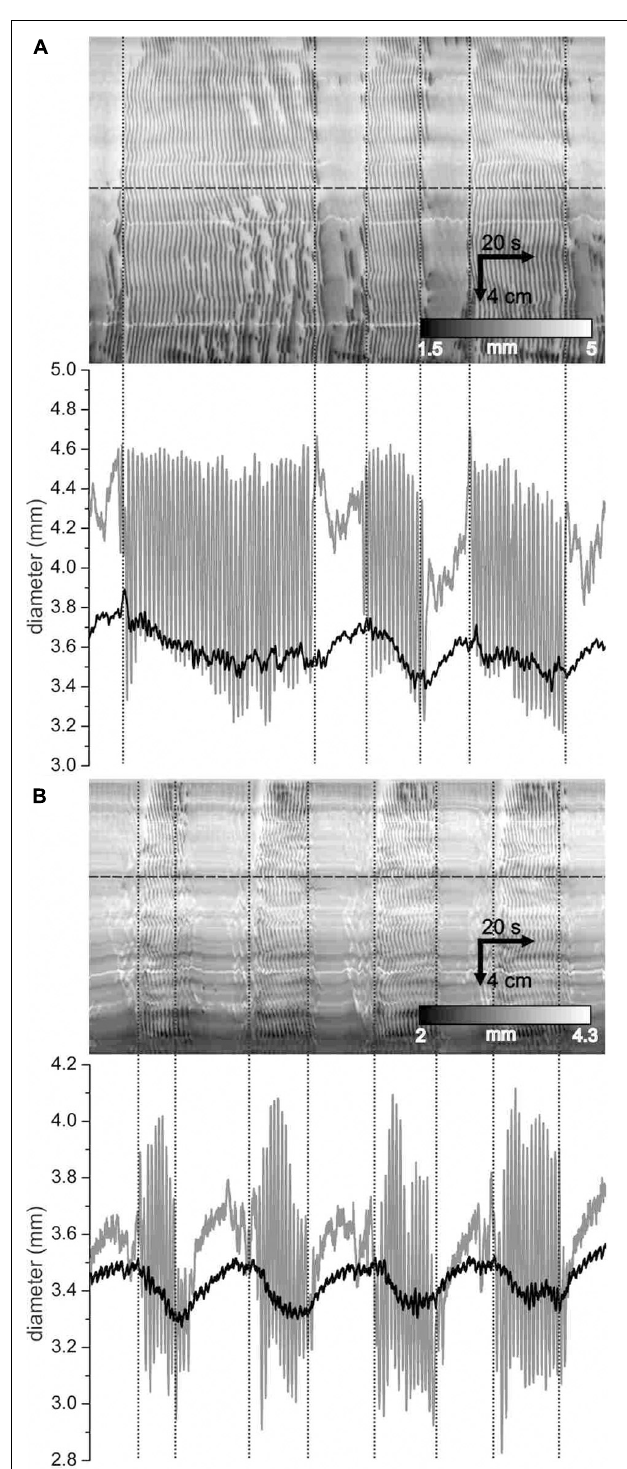
FIGURE 10 | Distension of the intestine during gaps. (A,B) DMaps (top) and their mean diameter (bottom, black) for two different intestines under control conditions (A) and with 1 µ M SNP (B) . Diameter refers to the mean diameter across the whole extent of the intestine. Vertical dotted lines indicate cluster boundaries. At horizontal lines, a diameter map was created (bottom, gray